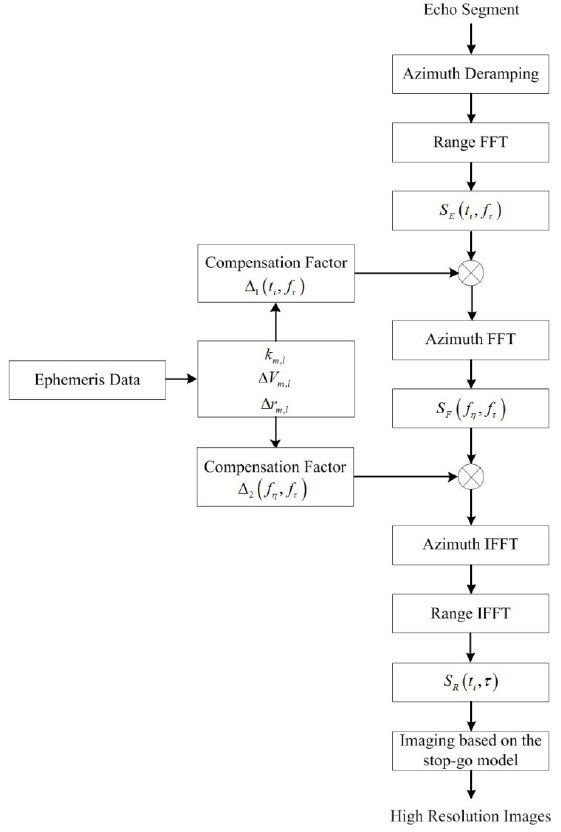
Figure 9. An imaging compensation algorithm based on the continuous tangent model.